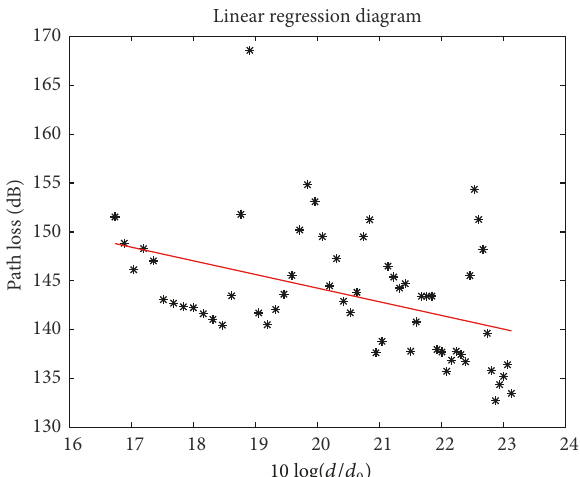
Figure 5: RouteC1 scatter-fitting line in 0.01/m 2 TX4.